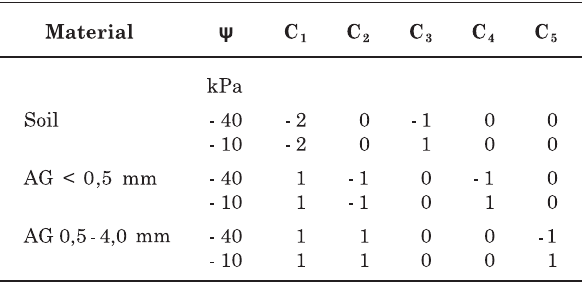
Table 2. Contrasts (C) used in the comparison of soil or aggregates (AG), and soil water potential ( ΨΨΨΨΨ ), in each management system (1)